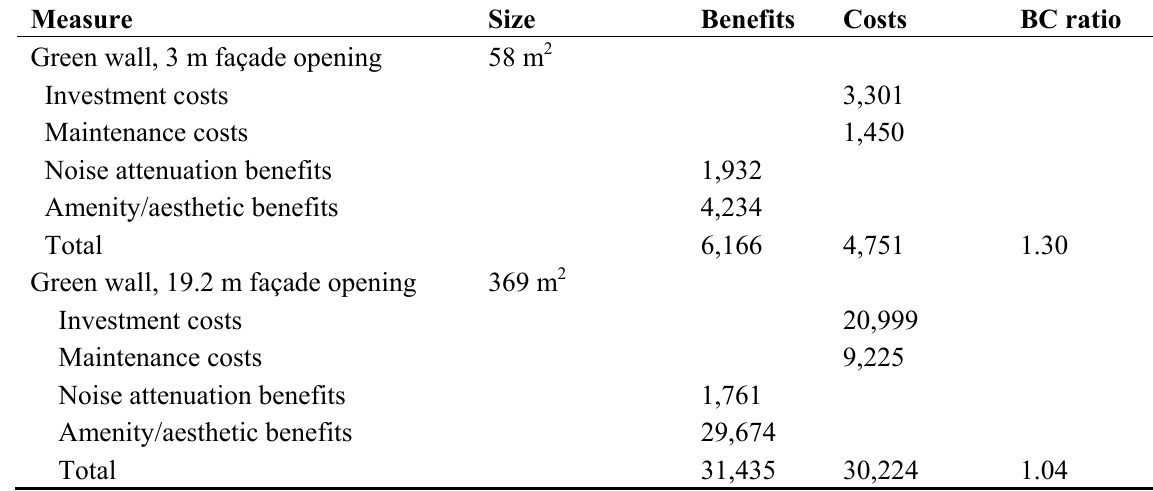
Table 4. Calculation of benefit-cost (B/C) ratios, for the two demonstration projects with differently sized green walls—3 m high and 19.2 m high, assuming a green wall unit price of 0.5 EUR (2010) per m 2 per person per year.